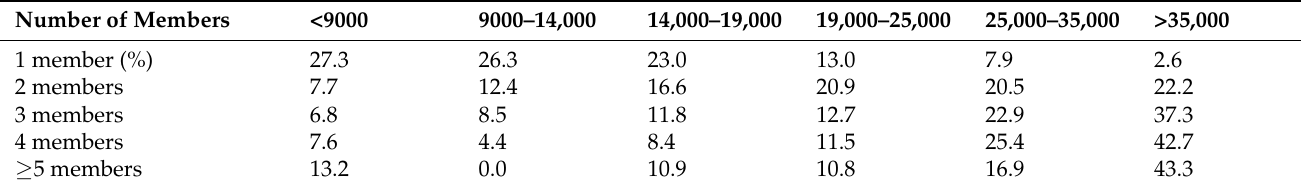
Table A2. Distribution of households according to income and number of members (IDESCAT: